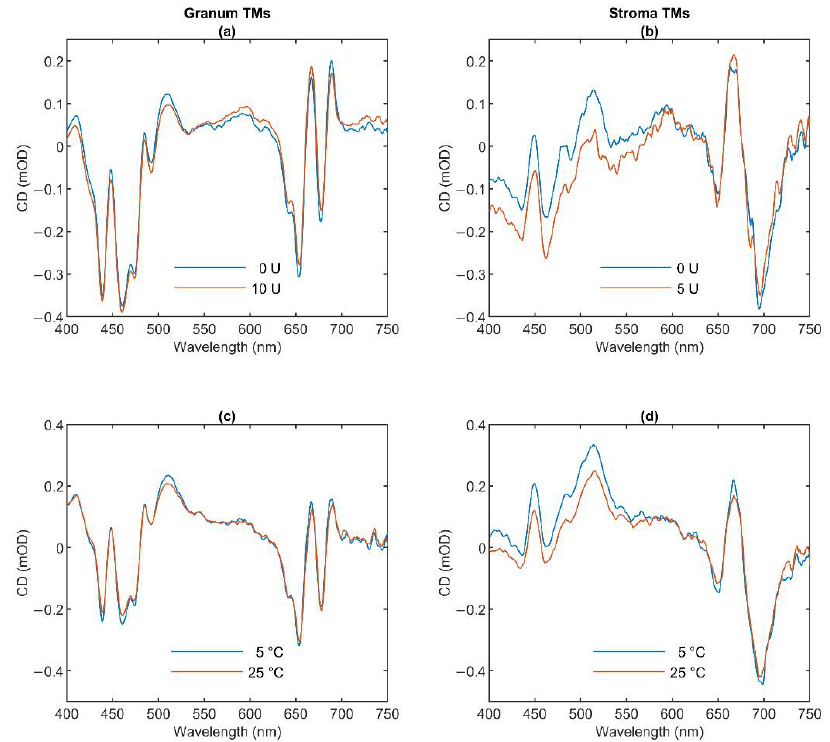
Figure 1. Circular dichroism (CD) of lipase-treated ( a , b ) and thermally treated ( c , d ) granum ( a , c ) and stroma ( b , d ) thylakoid membranes (TMs). The activity of the wheat germ lipase ( a , b ) was 0 U (blue curves) and 10 U for granum and 5 U for stroma TMs (red curves). The effect of temperature ( c,d ) was recorded at 5 °C (blue curves) and 25 °C (red curves). Four individual batches of granum TMs were measured and averaged. We used two different batches of stroma TMs for measuring the effects of thermal- and lipase treatments.